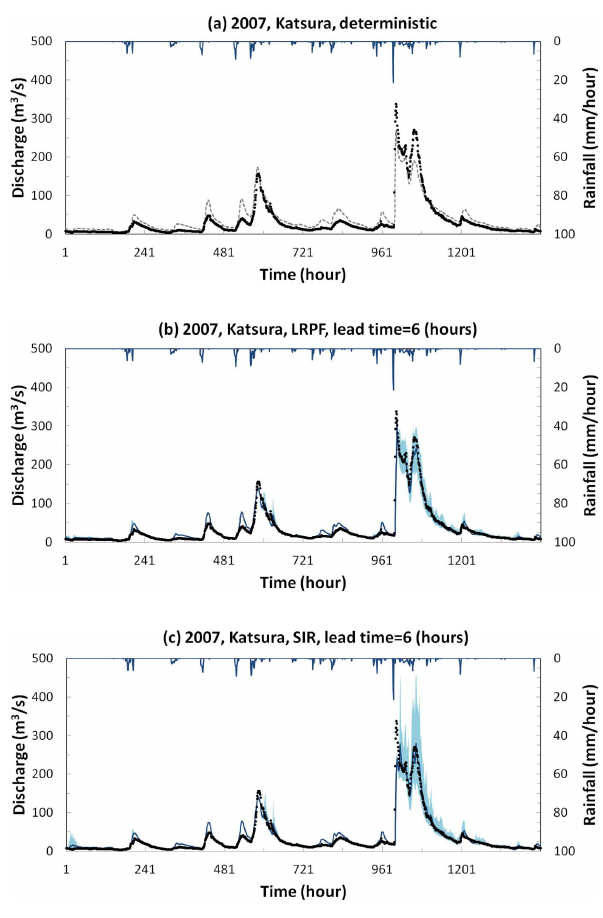
Fig. 7. Observed versus 6-h-lead forecasts at the Katsura station via LRPF and SIR (1 June–31 July 2007): (a) a deterministic modelling case; (b) LRPF; and (c) SIR. The blue line and area represent the mean value and 90% confidential intervals, respectively. A gray dashed line represents a deterministic modelling case. The black dots represent observed